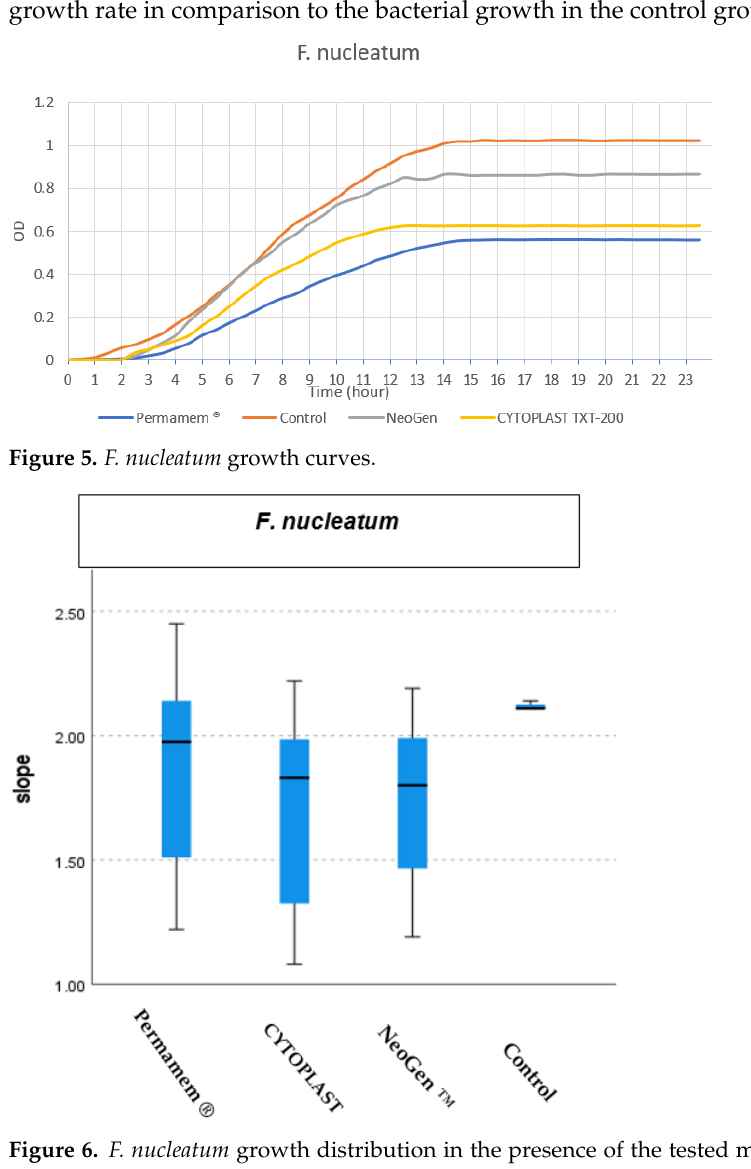
trol Figure 6. F. nucleatum growth distribution in the presence of the tested membranes and in a control group.